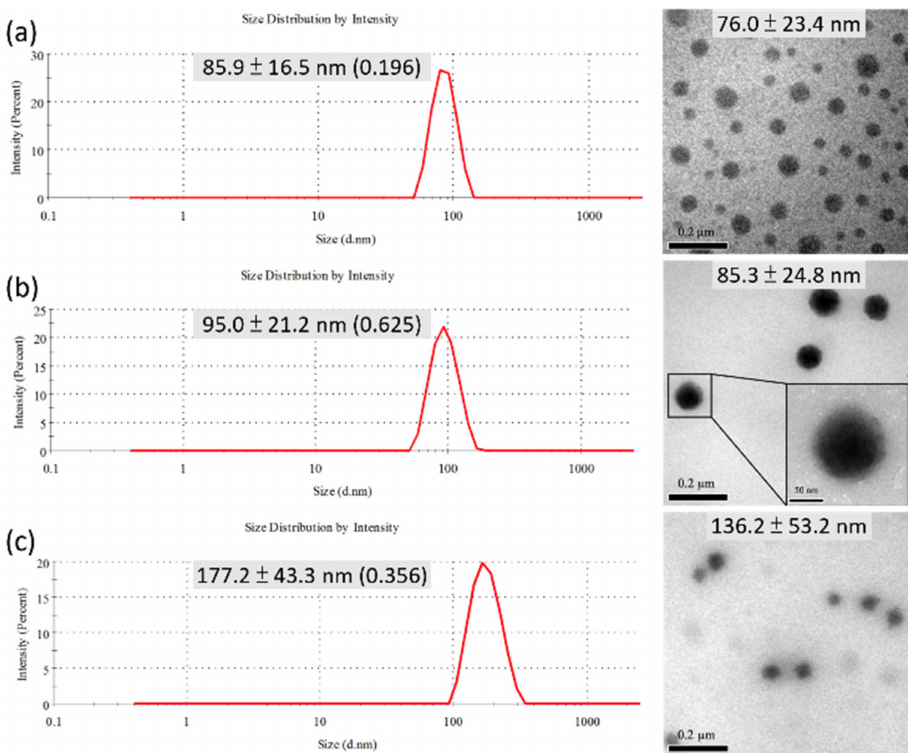
Figure 2. TEM images and DLS measurements (average particle size (PdI)) of ( a ) NOCC/Dox/HA- SH, ( b ) SH-HA-Dopa-CaP/siRNA and ( c ) Dox/siRNA 2-in-1 chimeric NPs.